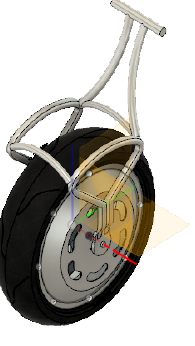
Figure 1. Basic design sketch of the